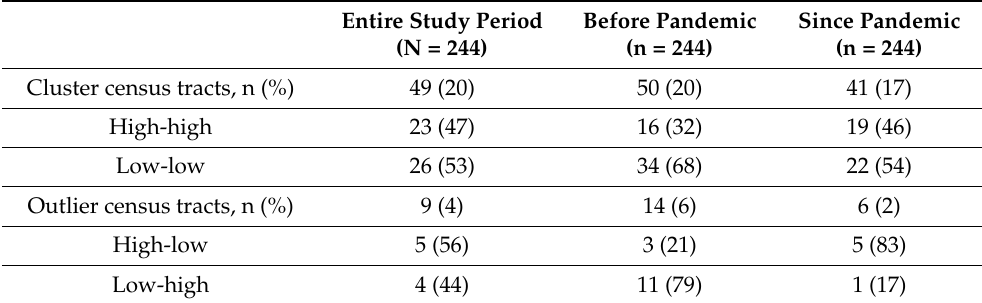
Table 3. Results of the Local Indicators for Spatial Association (LISA) analysis for rates of ambulance calls based on census tracts, percentages rounded to integers.